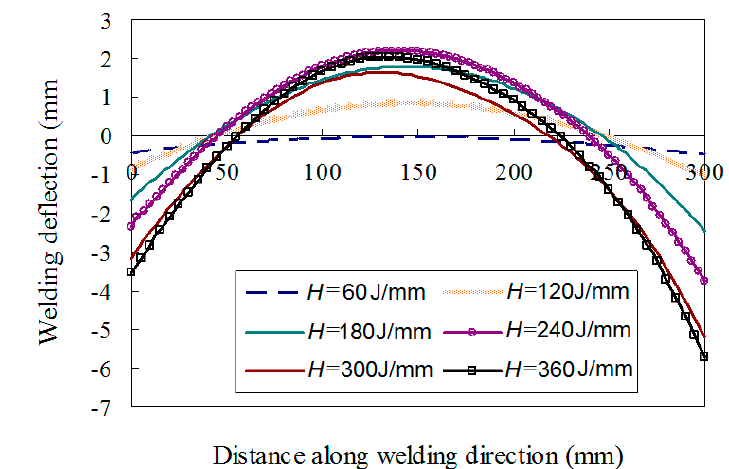
Figure 16. Deflection profile along the weld line.